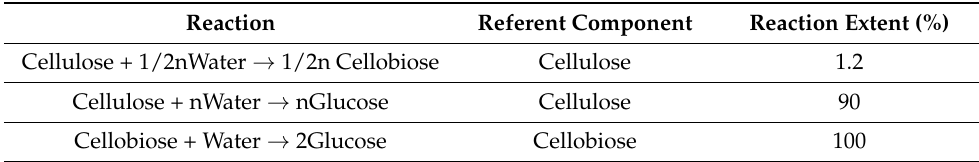
Table 2. Hydrolysis reactions and reaction extents.